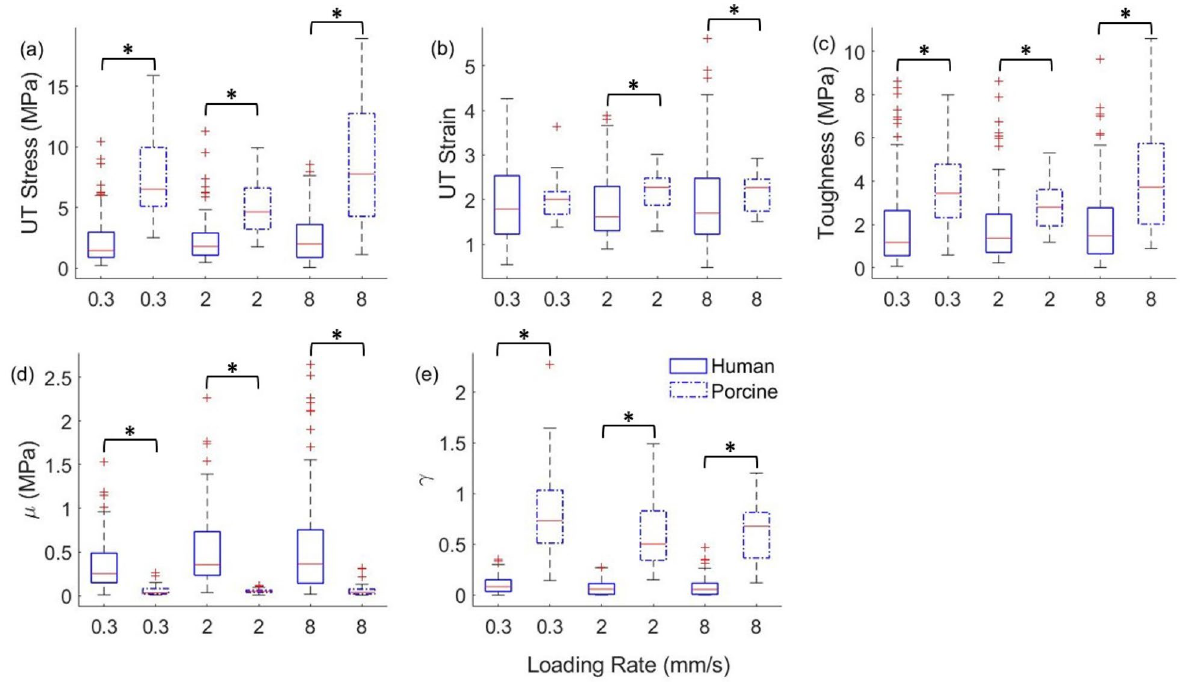
Figure 2. The box plots of ( a ) ultimate tensile stress (UT Stress), ( b ) ultimate tensile strain (UT Strain), ( c ) toughness, and parameters ( d ) μ and ( e ) γ of the Veronda-Westmann model for the full thickness burned human and porcine skin tissue at loading rates of 0.3 mm/s, 2.0 mm/s, and 8.0 mm/s. ‘*’ indicates a significant difference in the Wilcoxon rank-sum test or the t -test for unequal